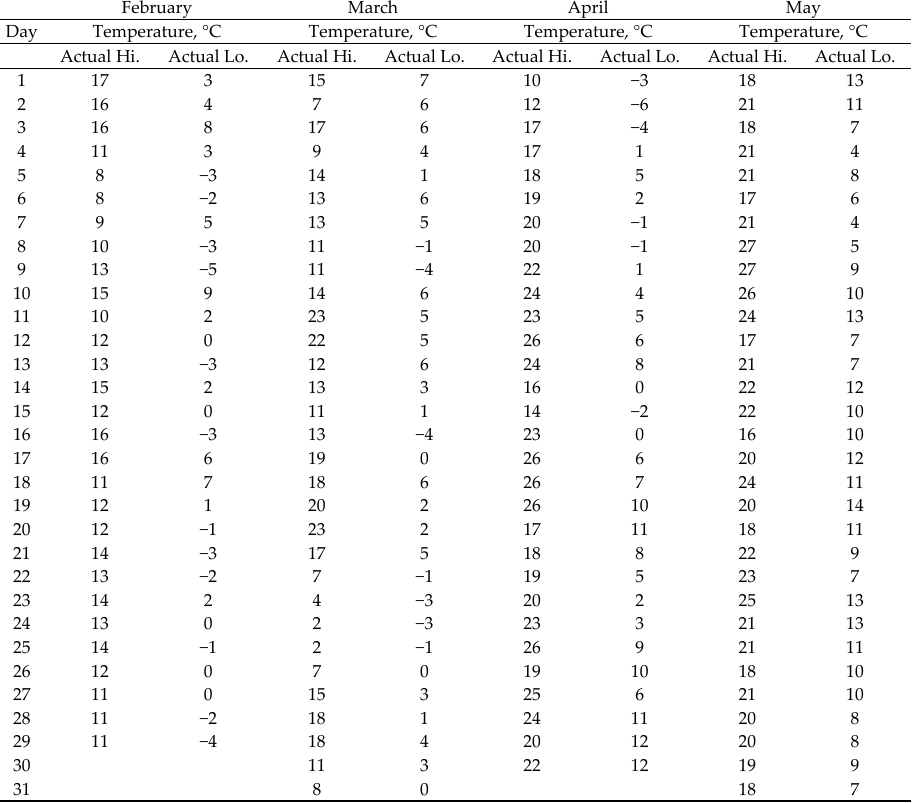
Figure 1. Temperatures in the city of Zagreb from February to the end of May 2020